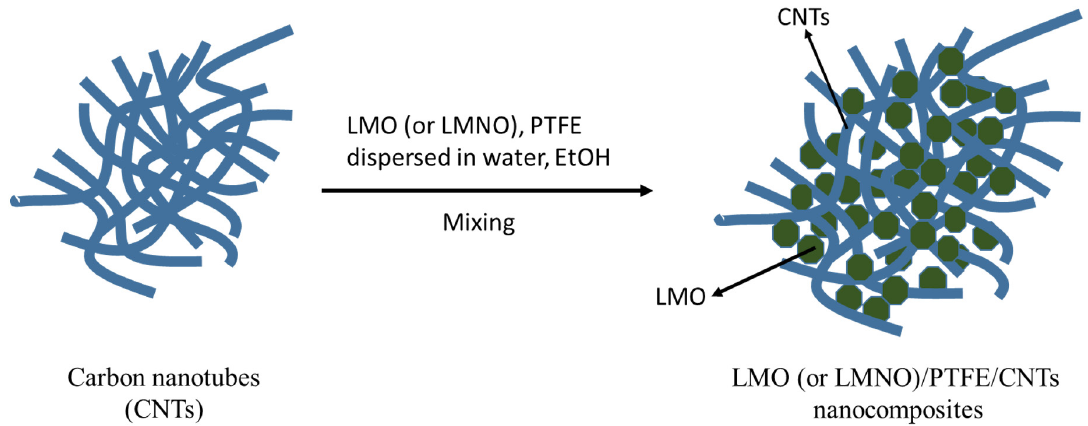
Figure 1. Schematic illustration of LMO (LNMO)/CNTs nanocomposites by mixing